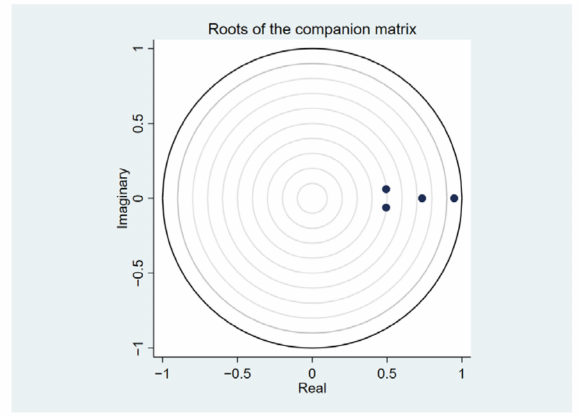
Figure 6. Panel AR root